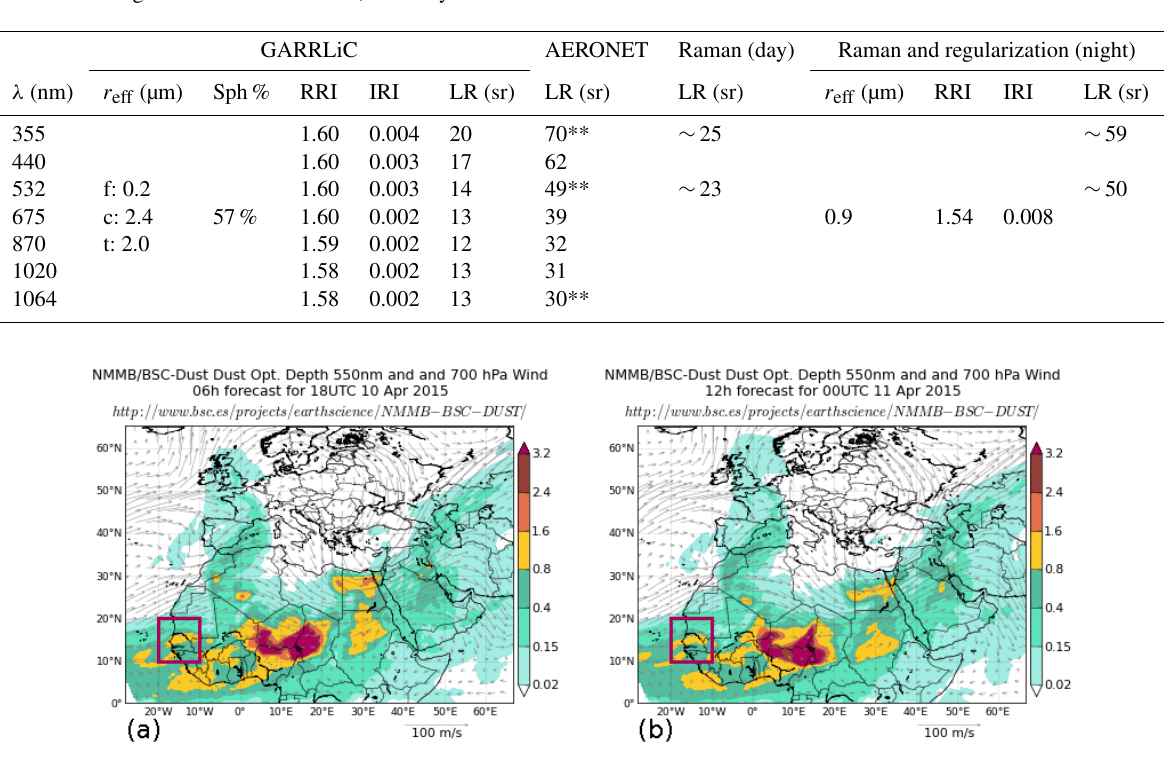
Table 3. Aerosol properties during the dust event over the Dakar site on 10 April 2015. The LR values marked by ** were retrieved by the LIRIC algorithm. Only the values given for all the wavelengths refer to the column-integrated property. Day: AOD 440nm ≈ 1 . 53 ± 0 . 04;